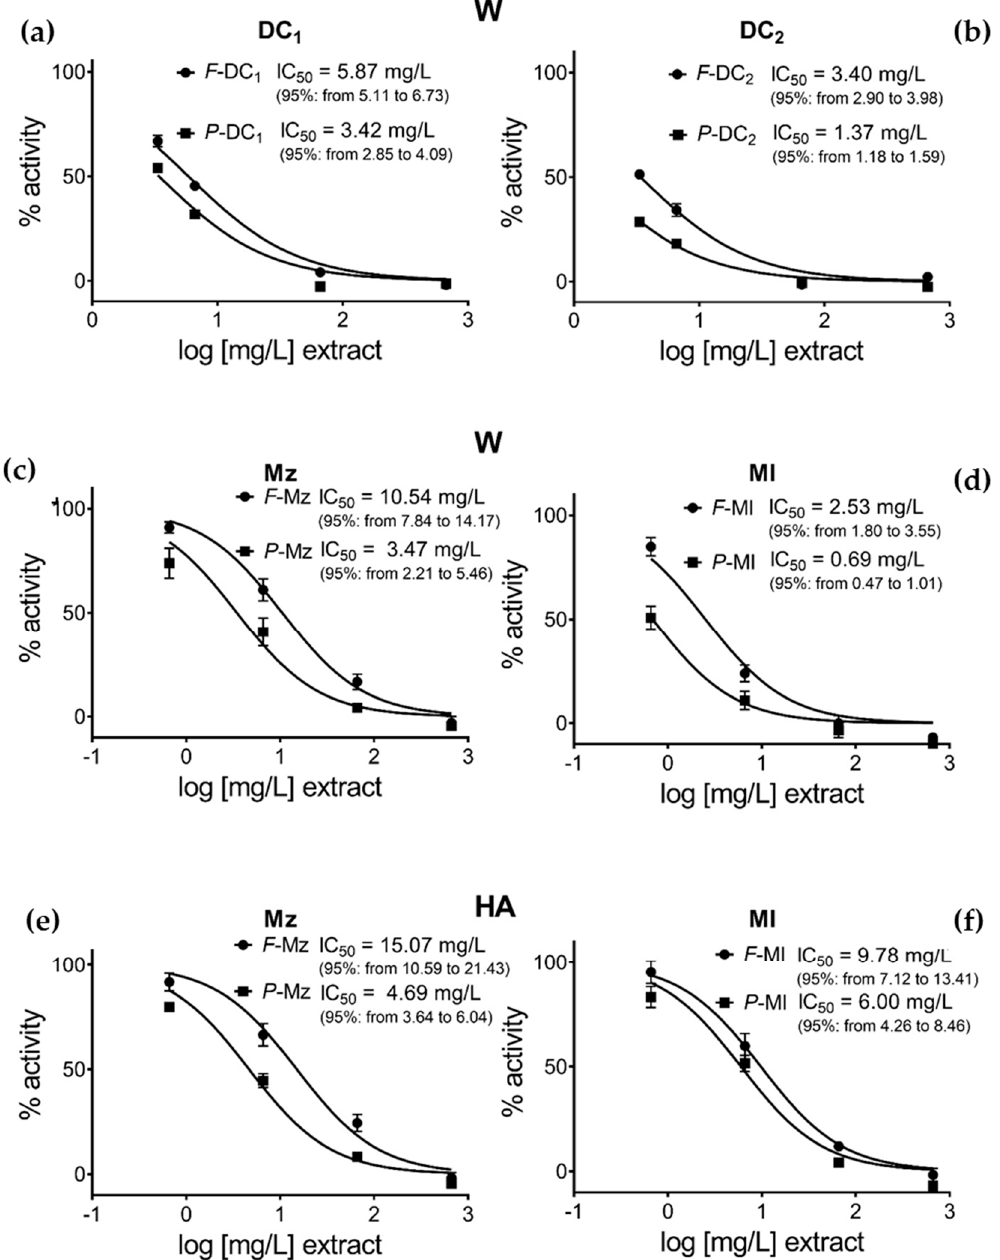
Figure 3. Comparison of the effects of the different obtained extracts on PDIA3 activity: ( a ) DC 1 aqueous extract; ( b ) DC 2 aqueous extract; ( c ) Mz aqueous extract; ( d ) Ml aqueous extract; ( e ) Mz hydroalcoholic extract; ( f ) Ml hydroalcoholic extract.